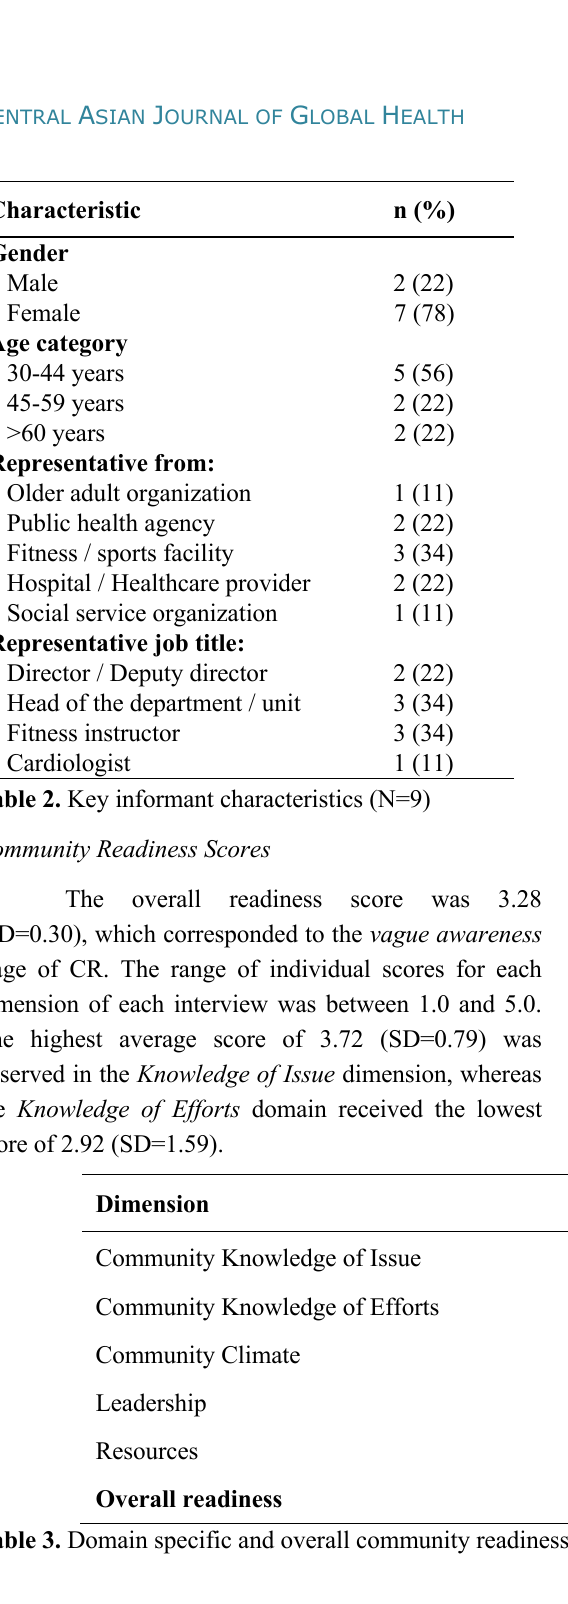
Table 3 represents consensus scores across each dimension based on all key informant interviews. The results suggested that four out of five dimensions were at vague awareness phase of CR. The only exception was